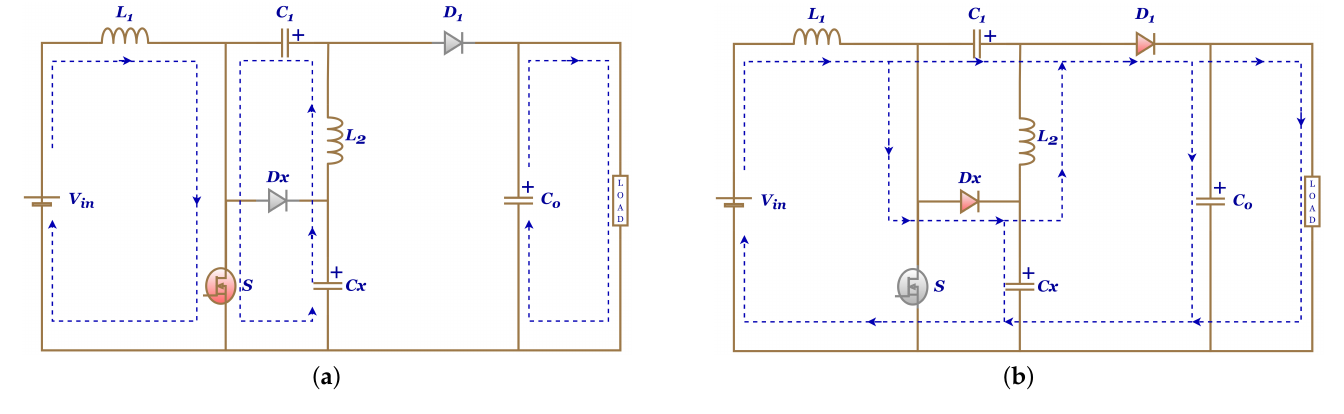
Figure 22. 1st M-SEPIC operation: ( a ) S closed, and ( b ) S